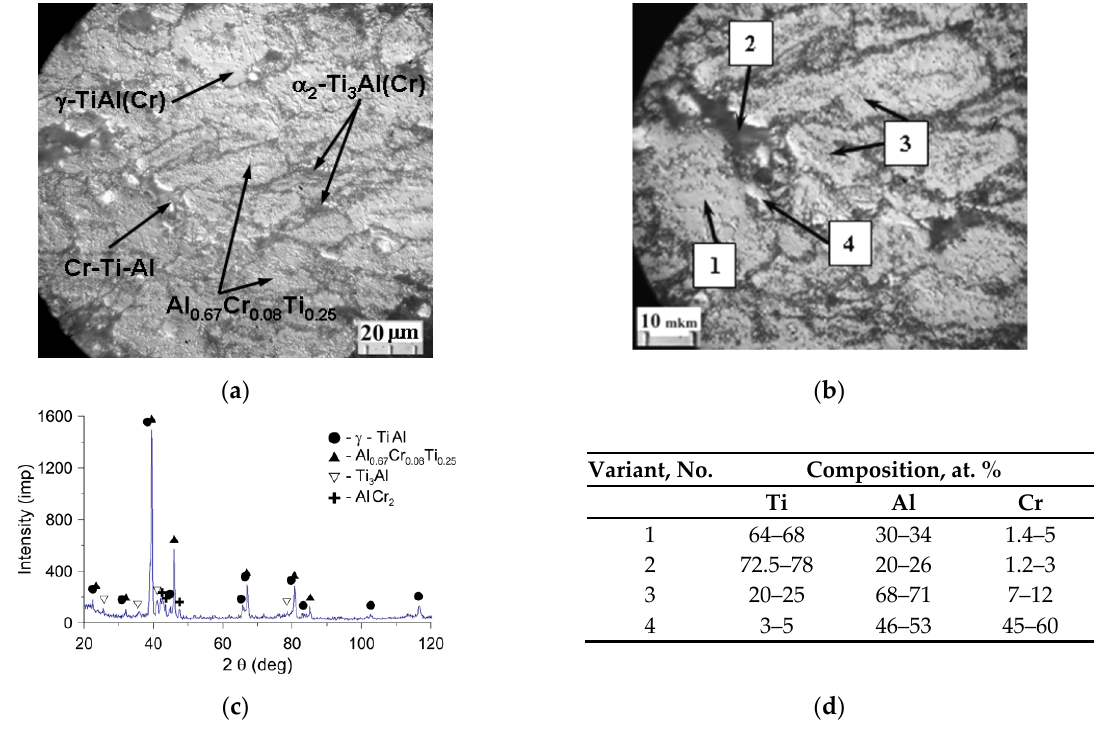
Figure 2. Microstructure and phase composition of the synthesized SHS powder of the Ti-46Al-8Cr system before grinding: ( a , b ) structure; ( c ) radiograph; ( d ) results of the micro X-ray spectral analysis (MRSA).